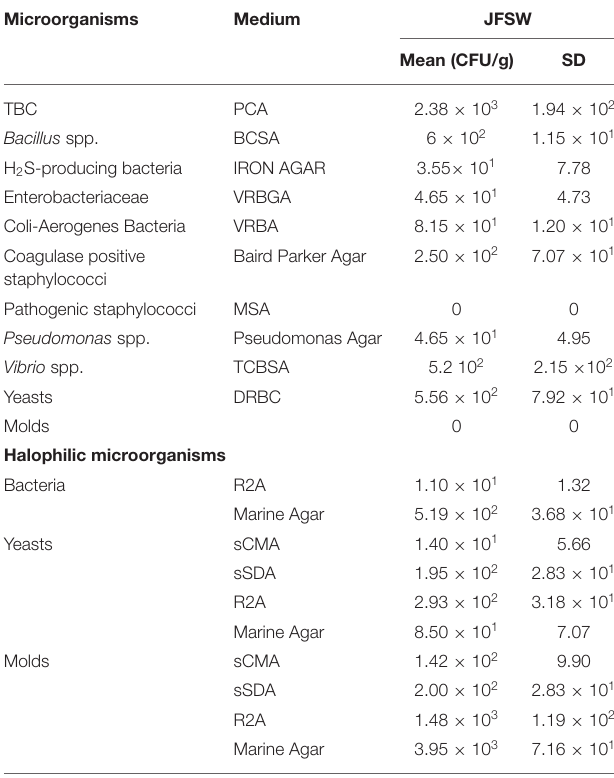
TABLE 1 | Microbiological analyses of jellyfish washed with sterile sea water (JFSW)